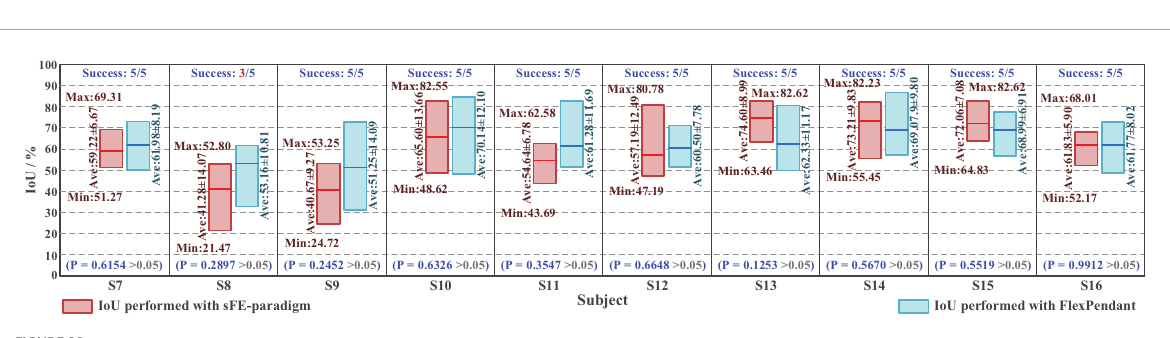
FIGURE20 The intersection over union (IoU) of placement deviation in Task one with slight-facial expression (sFE)-paradigm and FlexPendant, where the short red line indicates the average.